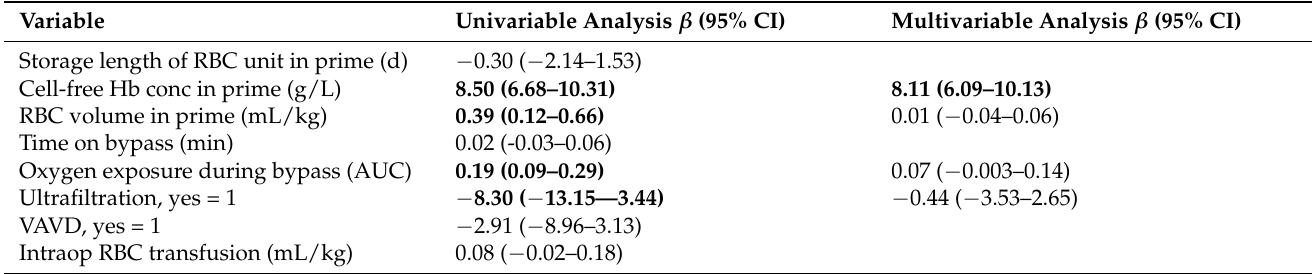
Figure 3. ( a ) Exposure to cell-free hemoglobin quantified as AUC plotted against concentration of cell- free hemoglobin in prime solution. Both parameters are log 10 -transformed given the nonparametric distribution. Shaded area represents 95% confidence interval for the regression model; ( b ) exposure to cell-free hemoglobin quantified as AUC plotted against oxygen exposure during cardiopulmonary bypass circulation. Both parameters are log 10 -transformed given the nonparametric distribution. Shaded area represents 95% confidence interval for the regression model; ( c ) exposure to cell-free hemoglobin quantified as AUC grouped by absence or presence of ultrafiltration during bypass circulation. Hb = hemoglobin, AUC = area under curve. Table 3. Evaluation of potential determinants of cell-free hemoglobin exposure during neonatal cardiopulmonary bypass by linear regression analysis. Values for β (95% CI) in bold denote statisti- cally significant relationships ( p < 0.05). Original data for evaluated determinants can be found in Table 2. CI = confidence interval, RBC = red blood cell, Hb = hemoglobin, AUC = area under curve, VAVD = vacuum-assisted venous